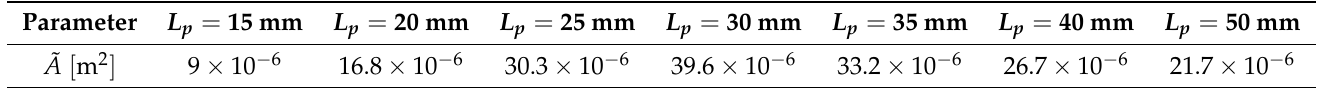
Figure 11. Fitted equivalent strip area ( ˜ A ) vs. the size of the probing loop L p for a constant tag size L tag = 30 mm. Table 1. Fitted equivalent conductor strip area for the additional capacitance for the sensor with L tag = 30